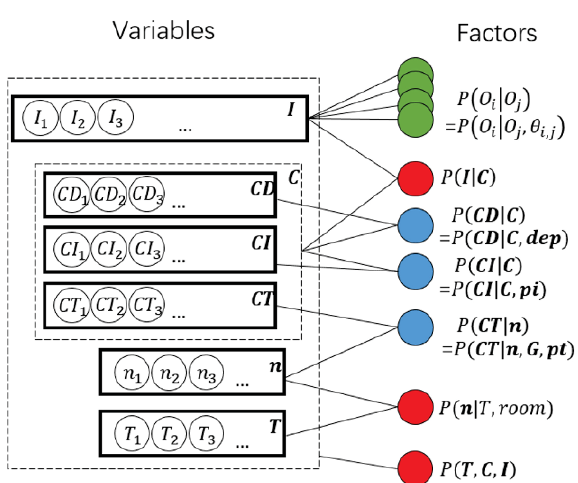
Fig. 4 Mapped factor graph of knowledge in indoor scene